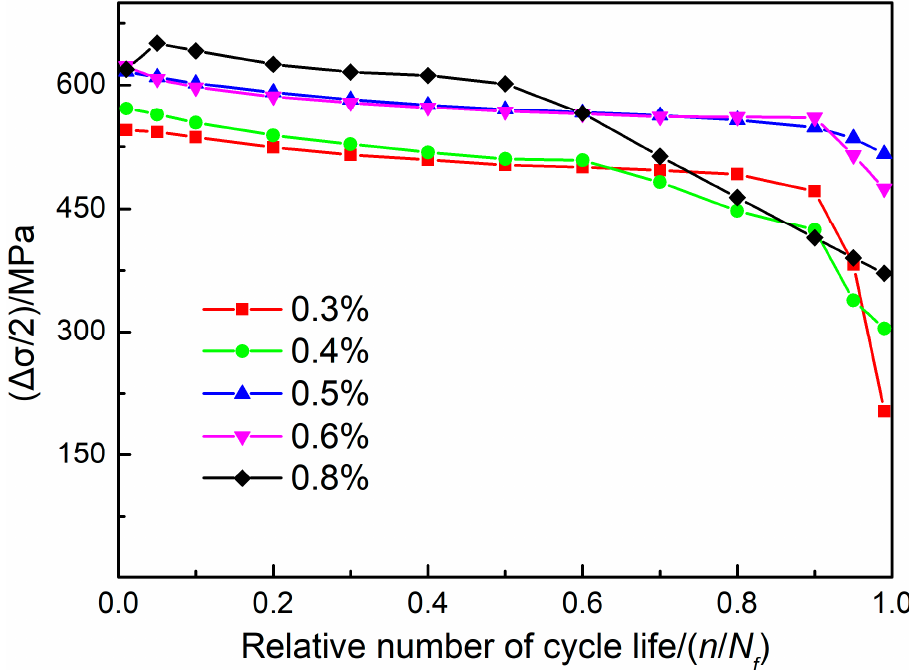
Figure 8. Changes in the amplitude of tensile stress of SAAM high-strength low-alloy steel workpieces under different strain amplitudes.